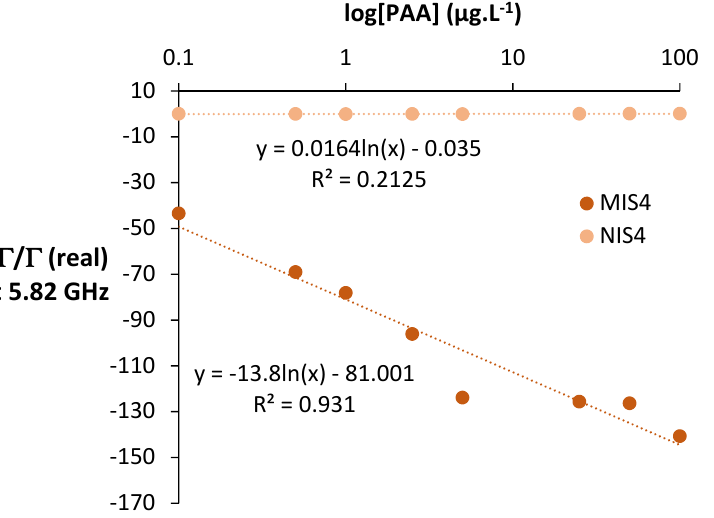
Figure 5. Effect of PAA concentration on the response of the MIS/NIS-microwave sensor in wa- ter/EtOH (90/10; v / v ). Uncertainty on ∆Γ / Γ = 0.1%. The correlation coefficients for linear correlation are over the critical values of the Pearson’s correlation coefficient in a one-tailed test at the level of significance of 1%. 8 points, 6 degree of freedom, R critical value = 0.789 < R observed = 0.965.